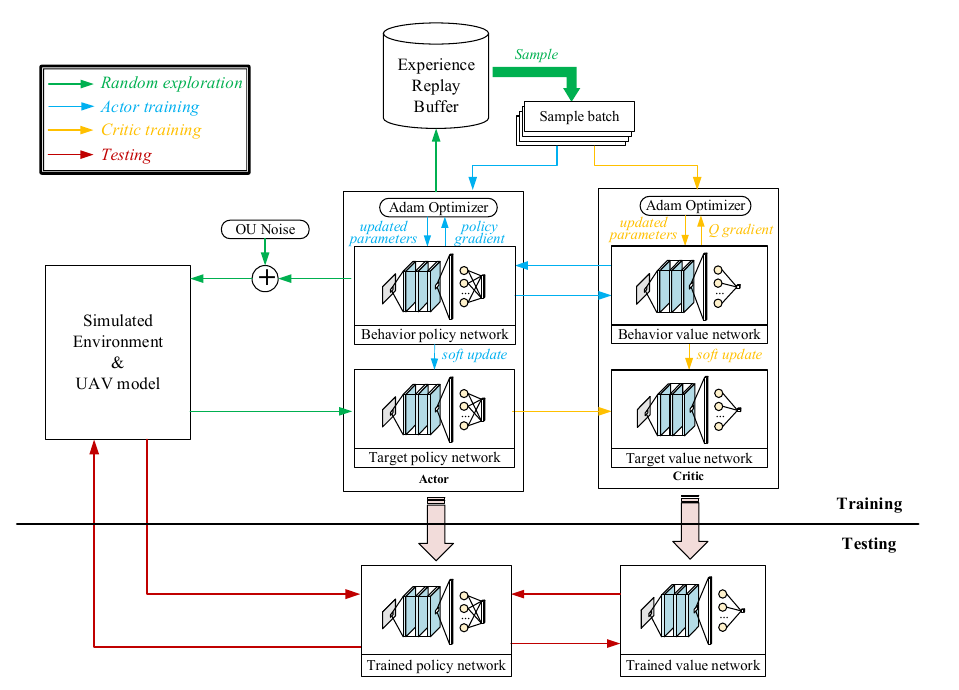
Figure 5. The diagram of the algorithm implementation.